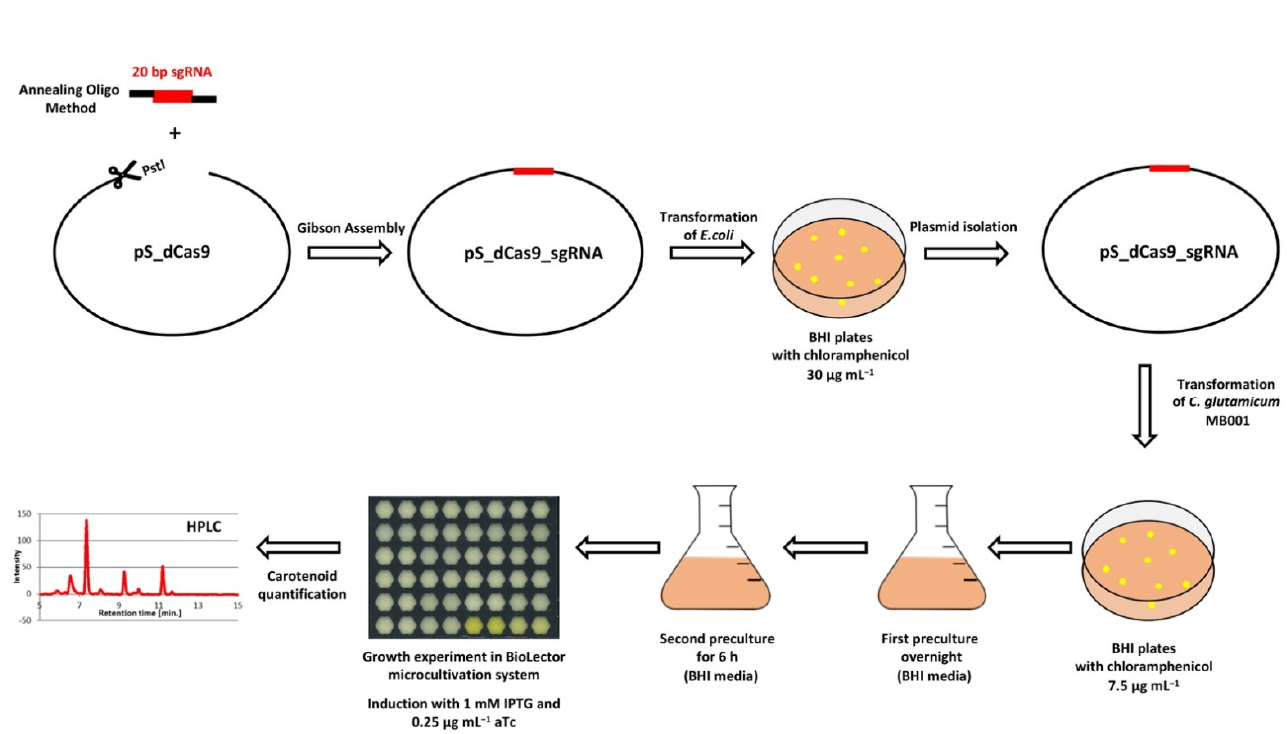
Figure 4. Workflow of CRISPRi library construction and screening in C. glutamicum MB001.